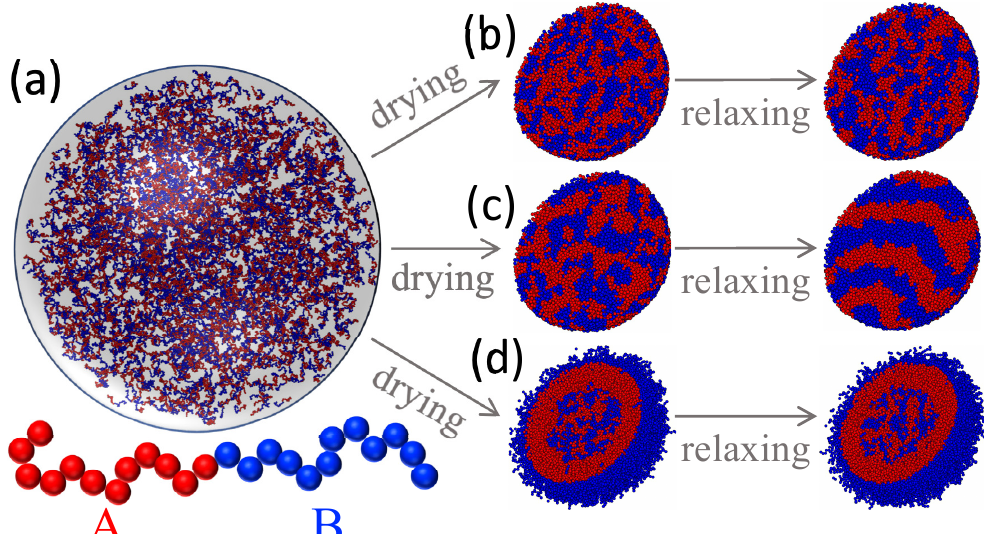
Figure 6. ( a ) A solution droplet of a diblock copolymer with N = 24 prior to drying. Depending on the cross repulsion between blocks and the block-interface interaction, polymeric particles with different morphologies are obtained after drying: ( b ) A particle with small domains of A (red) and B (blue) blocks is produced with θ = 0 for both blocks and (cid:101) AB = 2.0 (cid:101) ; ( c ) A particle with stripes of A and B blocks is produced with θ = 0 for both blocks and (cid:101) AB = 8.0 (cid:101) ; ( d ) A particle with a mixture core enclosed by a bilayer shell (i.e., a layer of B blocks on the outside and a layer of A blocks on the inside) is produced with θ = 0 for block A (red), θ = π /2 for block B (blue), and (cid:101) AB = 8.0 (cid:101) . In each case, the droplet is dried to a radius of 24 σ during 5 × 10 3 τ , followed by relaxation for 2 × 10 5 τ . For clarity, the droplets in ( b – d ) are sliced through the center to show the